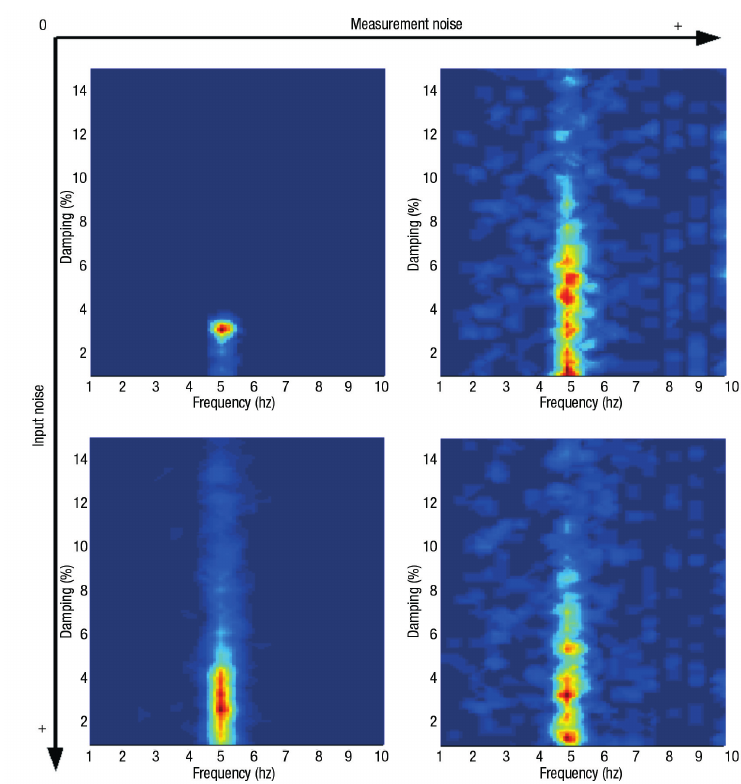
Fig. 2. Effects of increasing input and instrumental noise on the simulated recording atop a SDOF building.